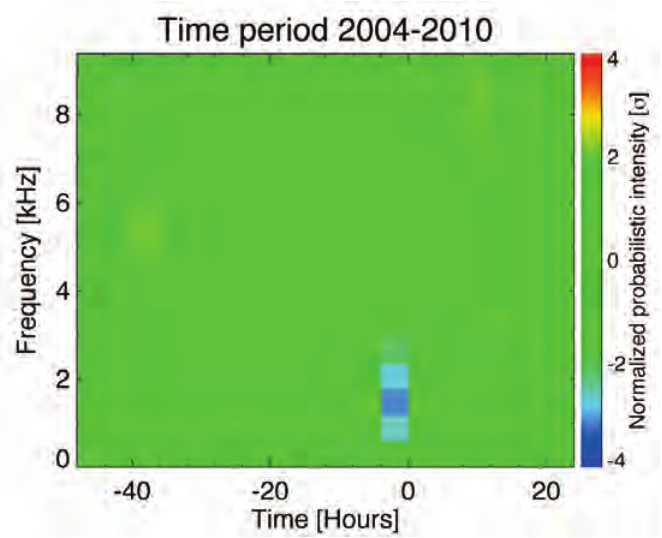
Figure 2. Frequency-time dependence of the normalized probabilistic intensity (see text) obtained from the night-time electric field data measured within 440 km from the epicenters of earthquakes with magnitudes ≥ 5.0 and depth ≤ 40